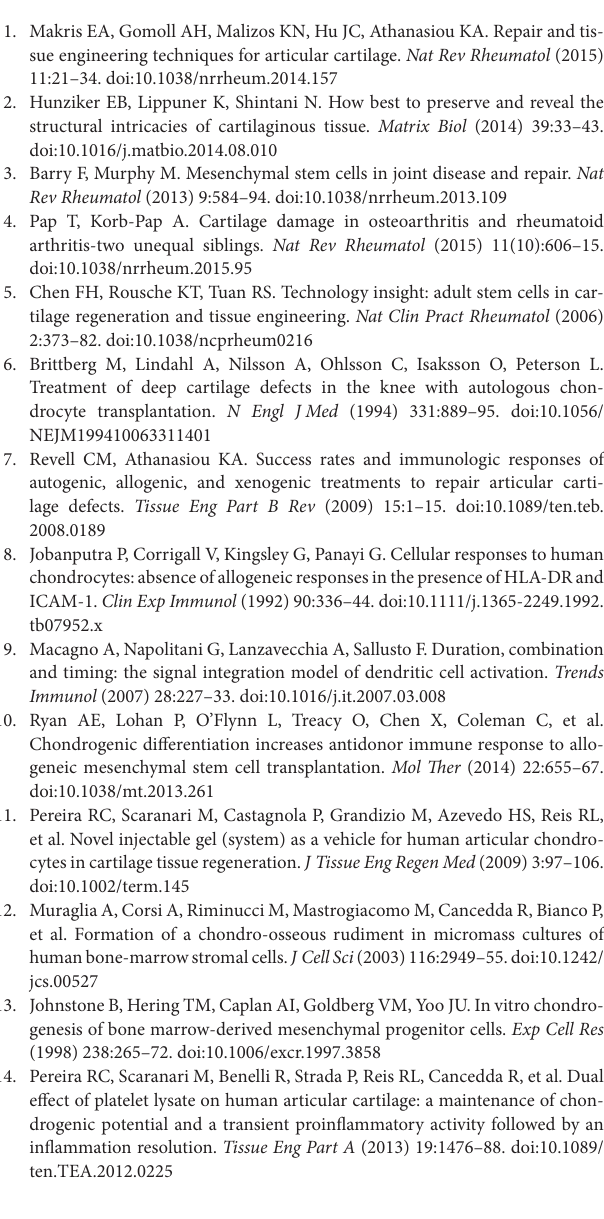
FigUre s4 | effect of hac on peripheral blood Mo to dendritic cell differentiation . Immunofluorescence analysis of Mo isolated from peripheral blood (PB monocytes) (first upper row), or cultured with GM-CSF (20 ng/ml) and IL-4 (20 ng/ml) (second row) or with GM-CSF + IL-4 and hAC (third row) or with GM-CSF + IL-4 + LPS (1 μ g/ml) (fourth row) or with GM-CSF + IL-4 + LPS and hAC (fifth row). GM-CSF and IL-4 (6 days of culture) were used to induce differentiation of PB Mo to iDC (second and third rows), while the addition of LPS (6 days of culture + additional 2 days with LPS) was used to further induce differentiation of iDC to mDC (fourth and fifth rows). Cells were harvested from cell culture wells and labeled with anti-CD1a-FITC, anti-CD14-PE-Cy7, anti-CD80- Violet, anti-CD83-APC, and anti-CD86-PE-conjugated antibodies. Five-color immunofluorescence analysis was performed with the CyAN ADP cytofluorimeter and at least 10,000 events for each dot plot have been analyzed. Analysis was performed on gated Mo as indicated in Figure S2 in Supplementary Material. Each subpanel was divided into four quadrants (upper left, single-positive cells for the indicated markers on y -axis; upper right double-positive cells co-expressing